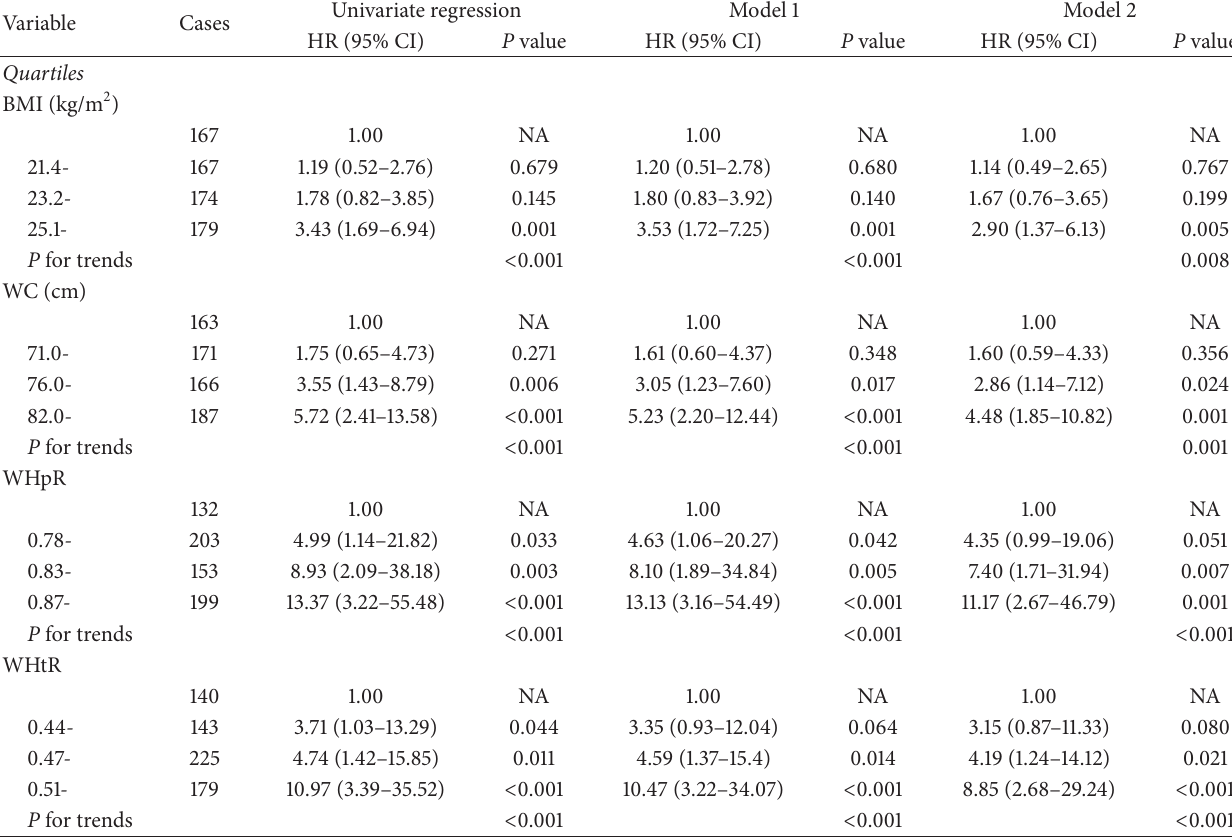
Table 2: Univariate and multivariate COX-regression models for prediction of diabetes in different